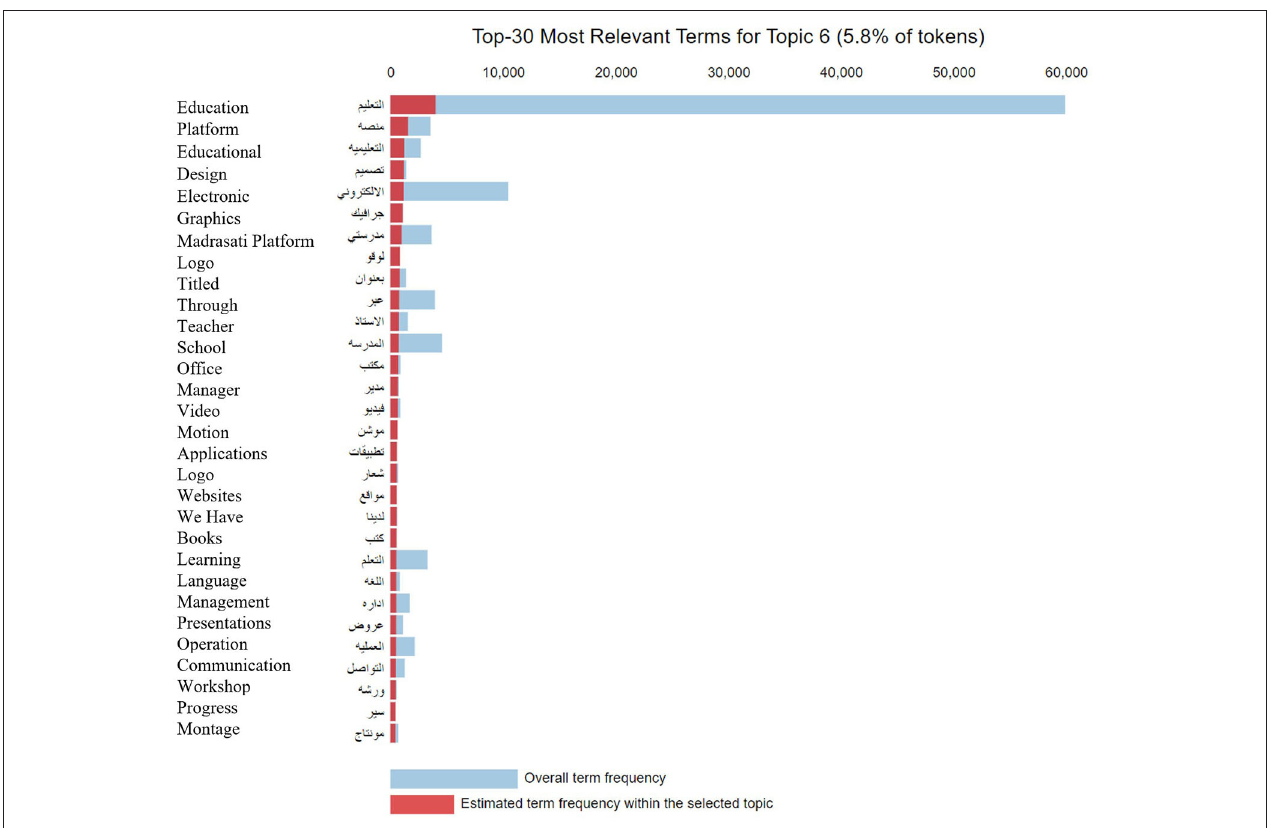
Figure 5 | The top 30 most relevant keywords/key terms by frequency (topic 6).